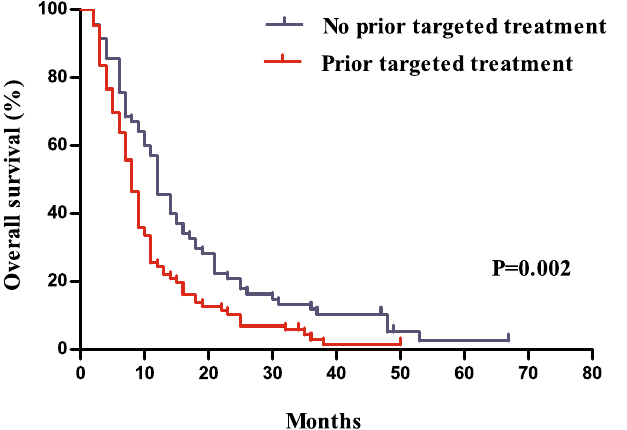
Figure 4. Comparison of overall survivals between patients with and without a history of the administration of targeted agents.